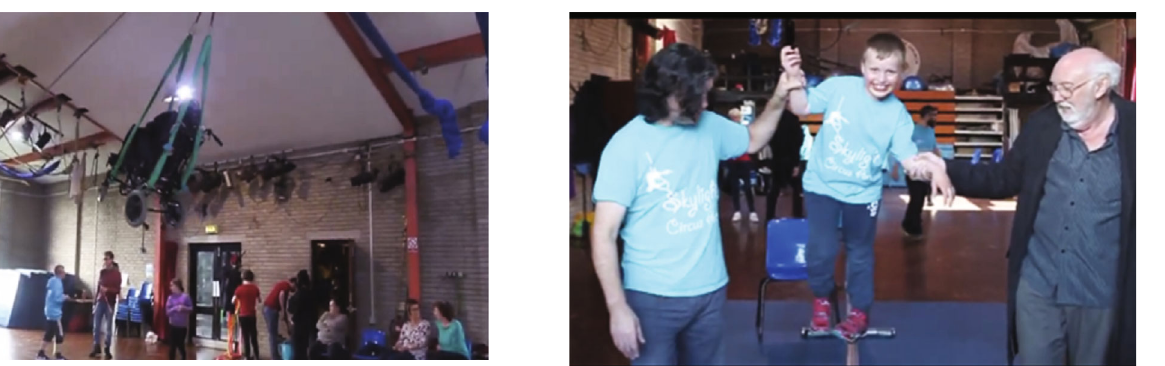
7: Participant receives a helping hand at a social circus class